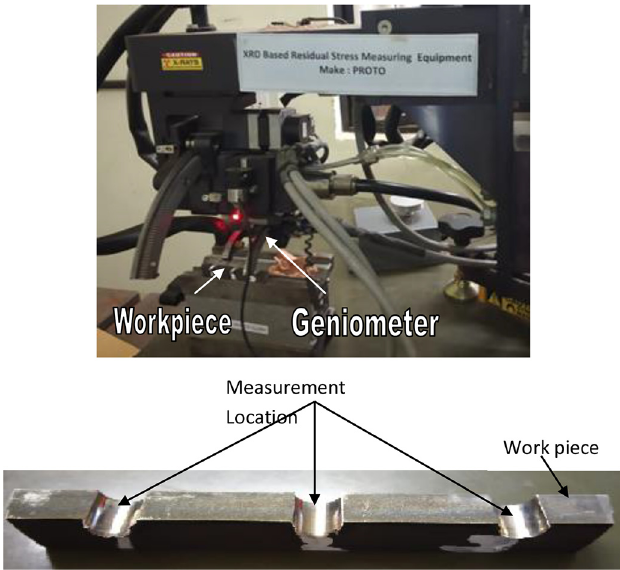
Fig. 2. X-ray Diffraction Stress